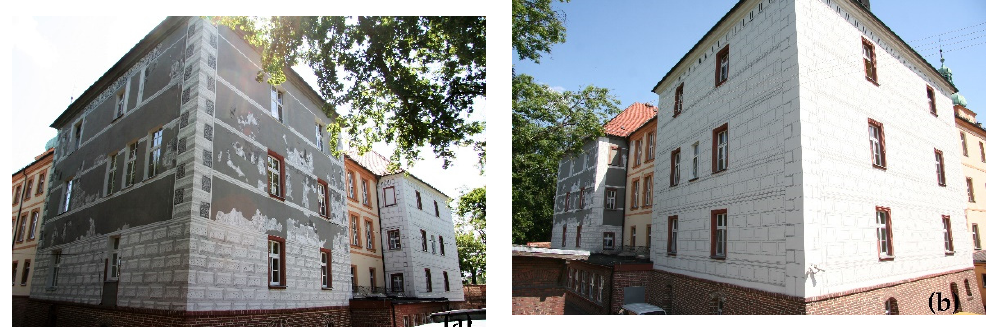
Figure 5. ( a ) Prószków castle, west elevation—north corner photo by the authors; ( b ) Prószków castle, west elevation— Figure 5. ( a ) Pr ó szk ó w castle, west elevation—north corner photo by the authors; ( b ) Pr ó szk ó w castle, west elevation—south south corner photo by the authors. corner photo by the